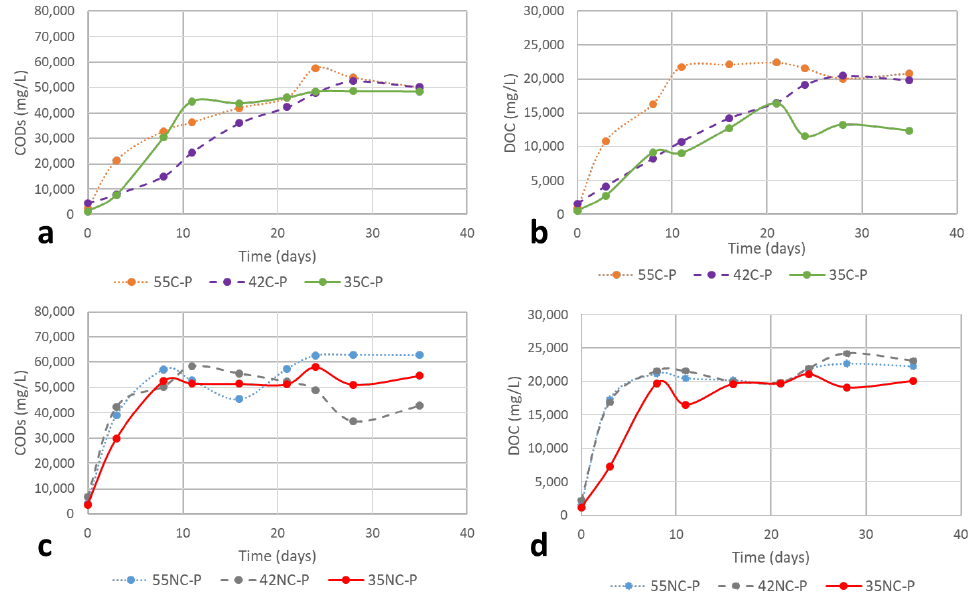
Figure 5. Evolution of organic matter solubilisation at thermophilic (55 °C), intermediate (42 °C) and mesophilic (35 °C) temperature regimes: ( a ) COD s from pre-treated chrome-tanned (C-P); ( b ) COD s from pre-treated chromium-free (NC-P); ( c ) DOC from pre-treated chrome-tanned (C-P); and ( d ) DOC from pre-treated chromium-free (NC-P) leather shavings.